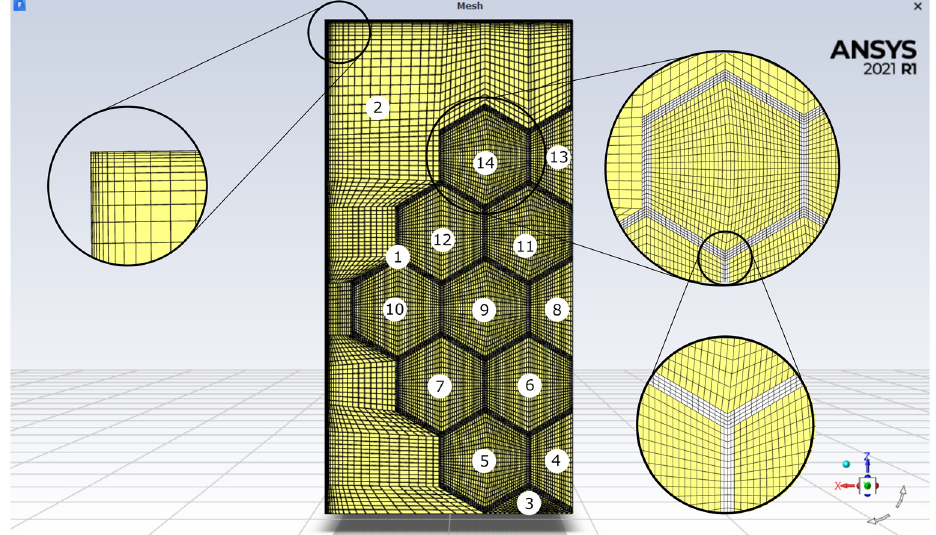
Figure 1. Test stand scheme: the thermocouples are placed in the center of the cells, in the middle of the structure.